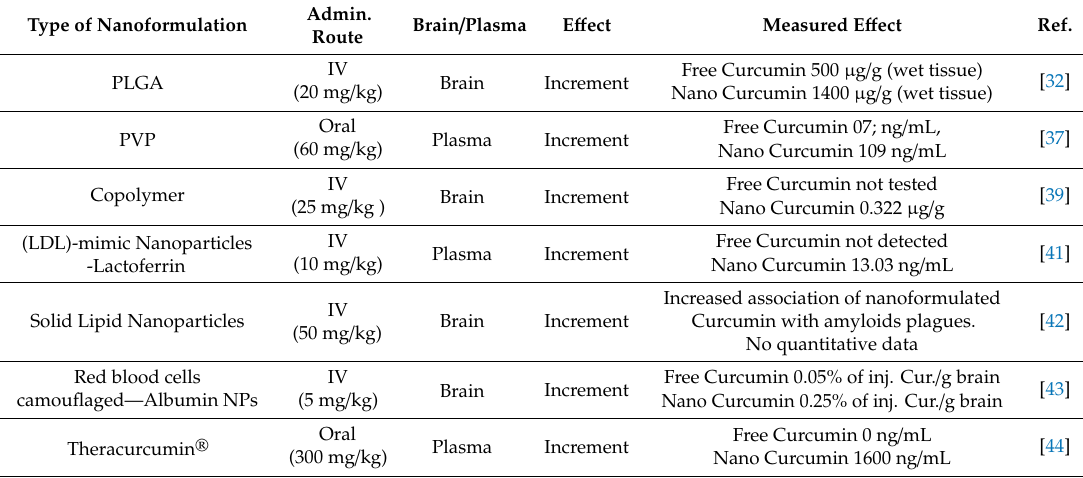
Table 1. Comparison of curcumin levels in brain or plasma when administered to animals as free agent or in nanoformulated